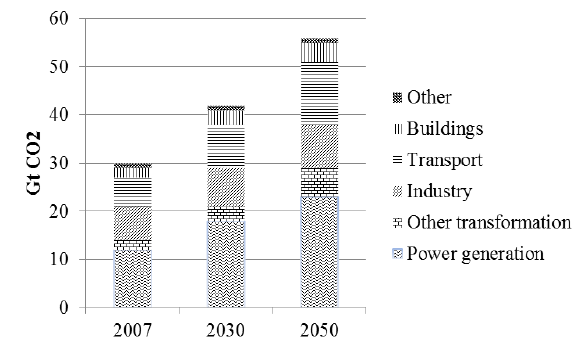
Figure 4: Distribution and prediction of global carbon dioxide emis- sions by